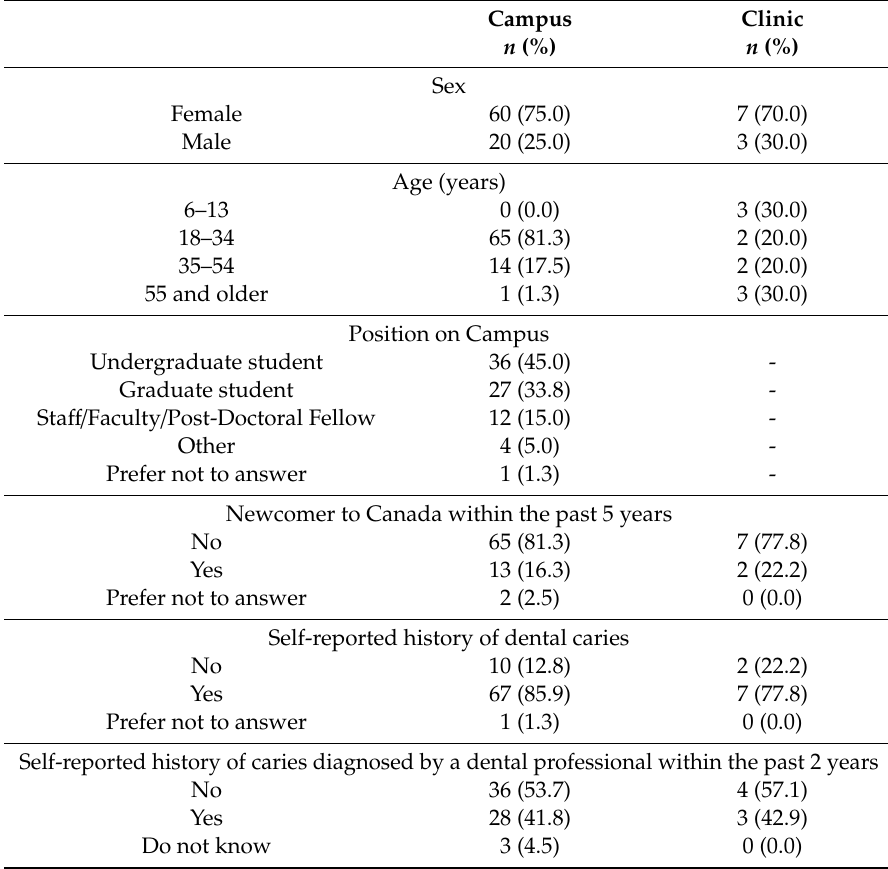
Table 1. Participant Demographic